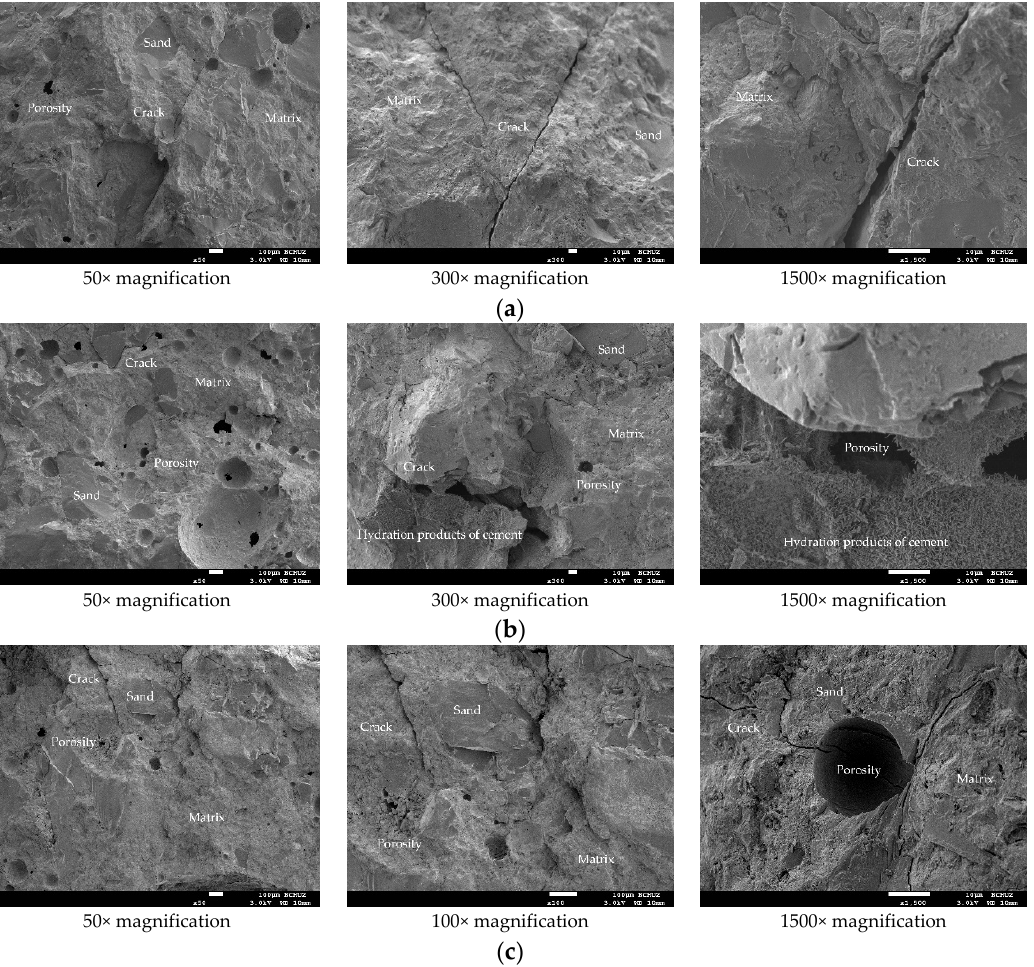
Figure 17. SEM observations of the HSC sample after being subjected to high temperatures: ( a ) 300 °C, ( b ) 400 °C, and ( c ) 500 °C.